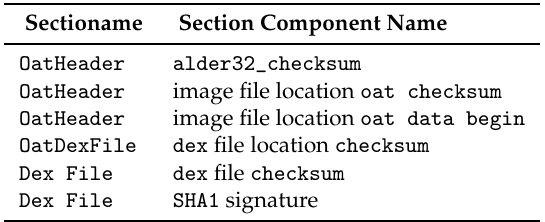
Table 1. List of OAT file checksum